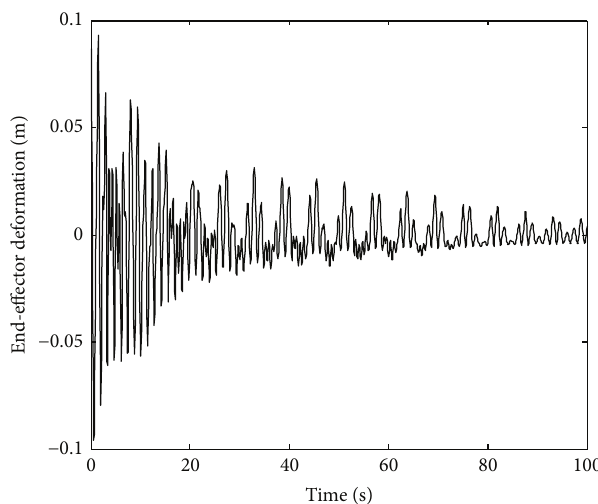
Figure 11: Damped modal amplitudes in moving flexible arm.